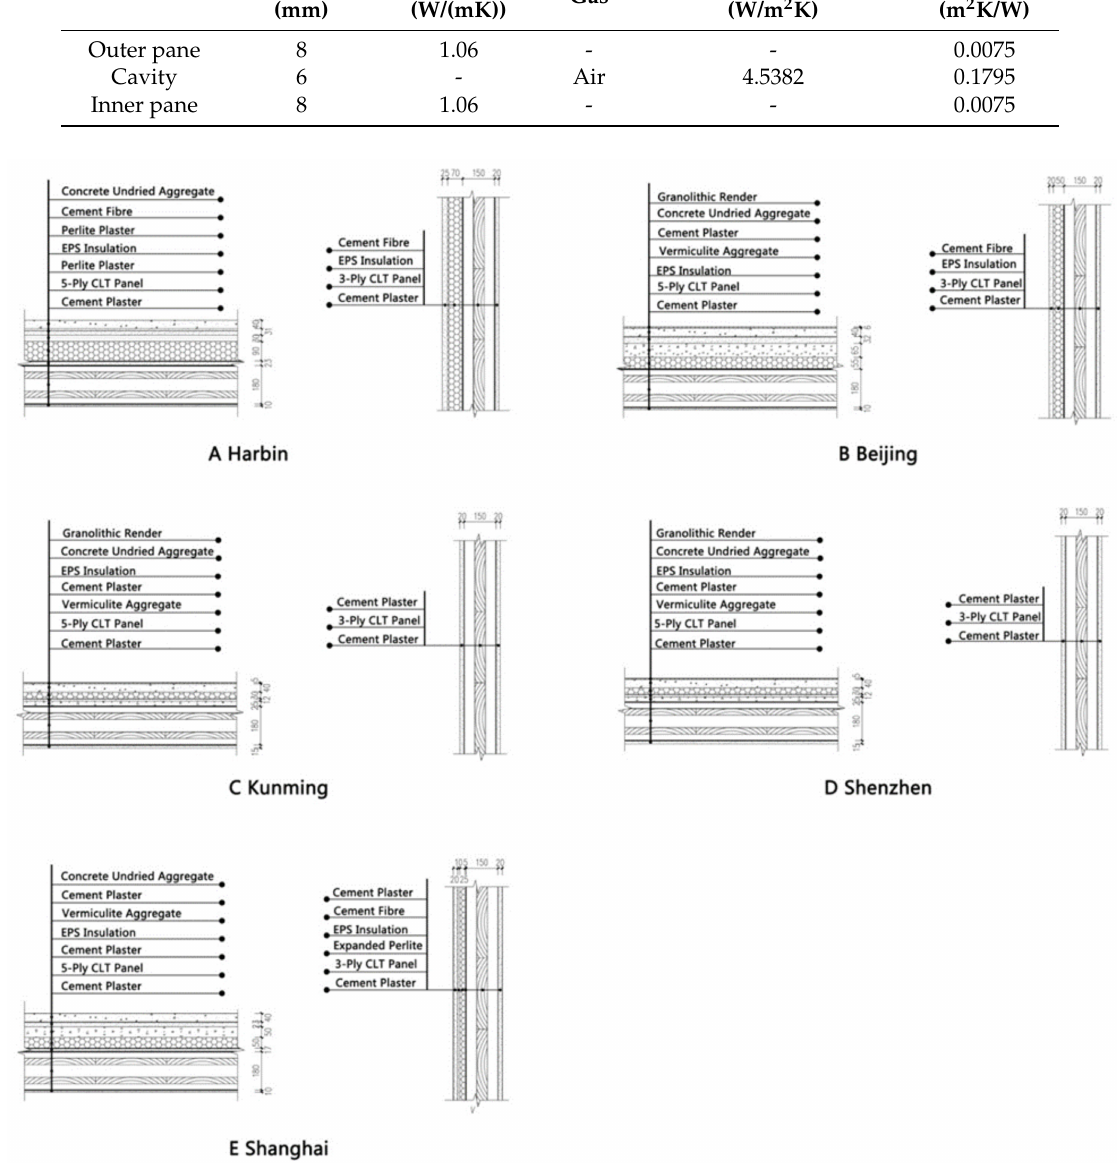
Figure 5. External wall and roof designs of the CLT building in the five